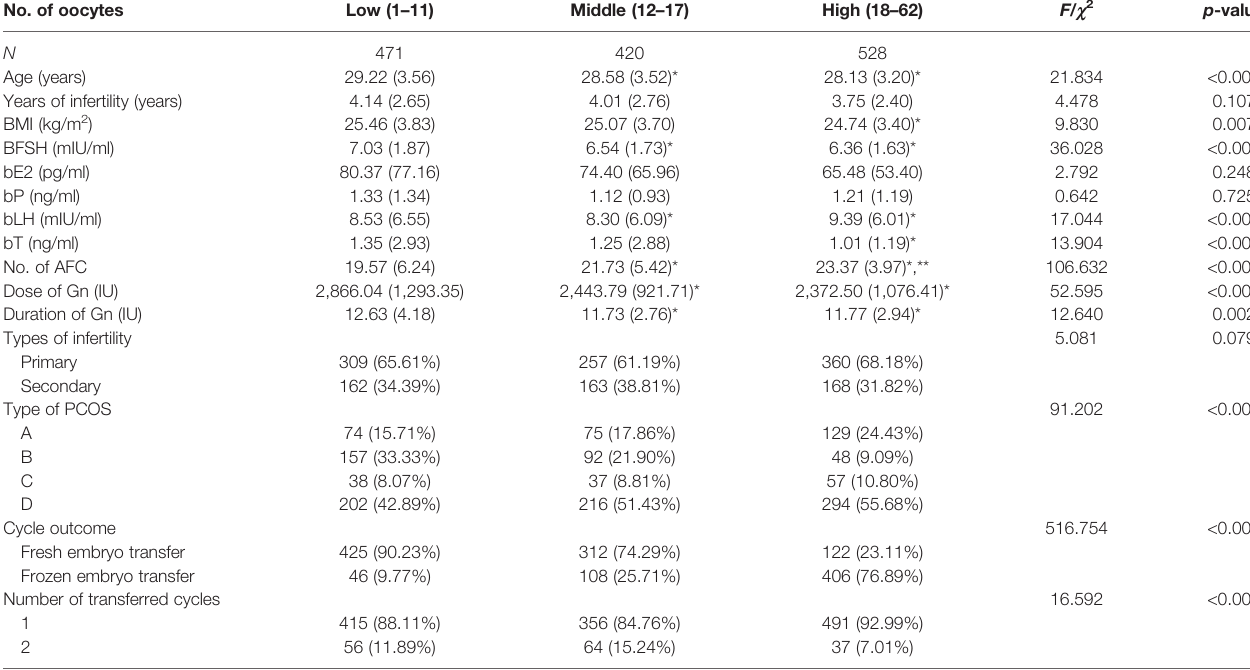
TABLE 1 | Patient/s baseline